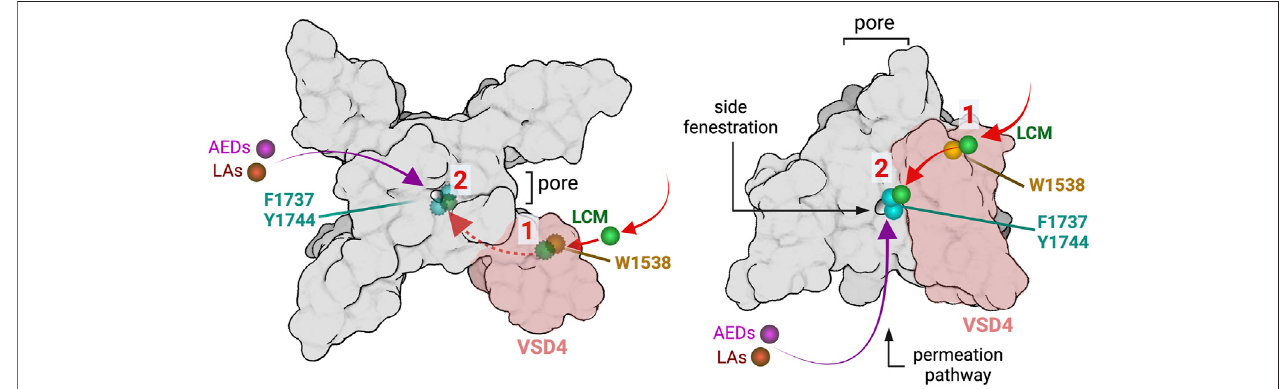
FIGURE 7 | Working hypotheses of lacosamide binding mechanisms. Schematic representation of the Na V 1.7 channel showing lacosamide (LCM; green) binding residues W1538 (shown in gold) and LA binding pore residues F1737 and Y1444 (shown in cyan). The left panel shows the Na V 1.7 channel visualized from the top, where,inordertoreachthepore,lacosamidemay fi rstbindtotheW1538regioninVSD4(shadedinpink),beforeaccessingtheporethroughthesidefenestrationwhere it exerts its inhibitory effects (not visible from the top, visualizable with dotted lines). This process would differ from typical AEDs (magenta) and LAs (red) that can reachtheporewithoutaninteractionwiththeW1538residue.Alternatively,theW1538residuemightrepresentanallostericsitemodulatinglacosamidebindingaf fi nityto F1737 and Y1444 in the pore. After coming into contact with VSD4 in the W1538 vicinity, lacosamide is able to access the pore and tightly bind to LA-binding residues. TherightpanelrepresentstheNa V 1.7channelfromtheside,topdown,and showsthesuggestedpathlacosamidemaytakethroughthepore ’ ssidefenestration via the W1538 residue or directly to the pore after some molecules become W1538-bound.